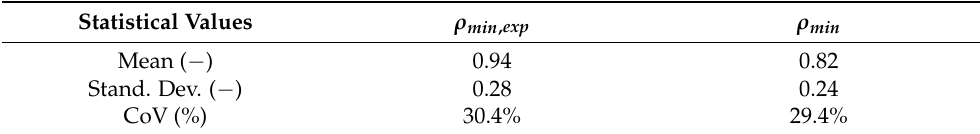
Table 7. Mean, standard deviation and CoV associated with the ratios ρ min and ρ min , exp .